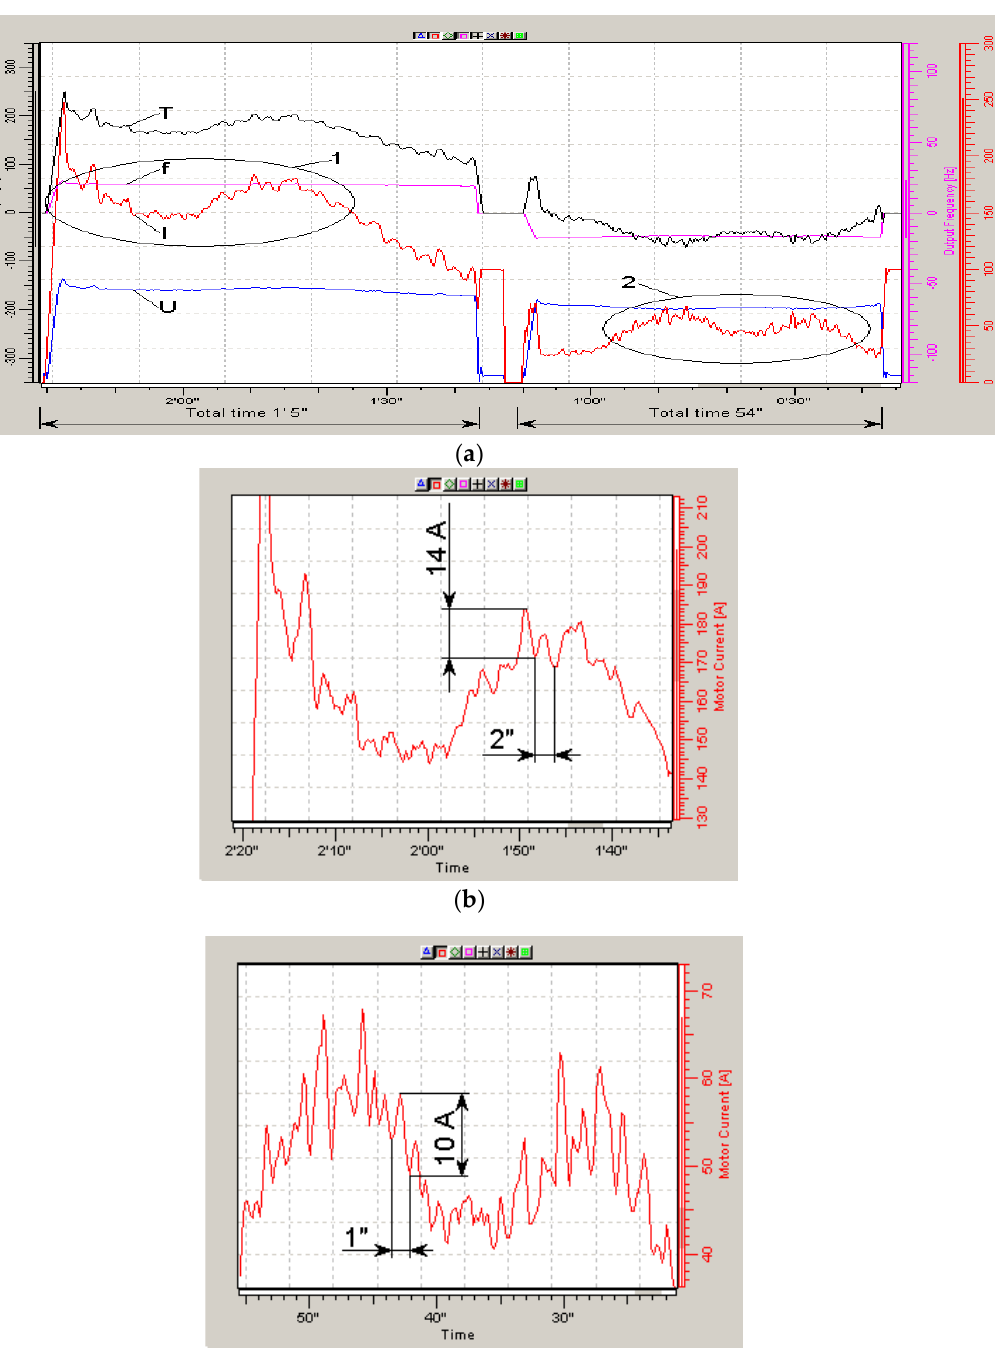
Figure 14. Diagrams of movement at high speed along track 4 with parameters U = 230 V, f = 17 Hz and U/f = 13.2 Fl ( a ) and extended sections 1 ( b ) and 2 ( c ) of the current diagrams.